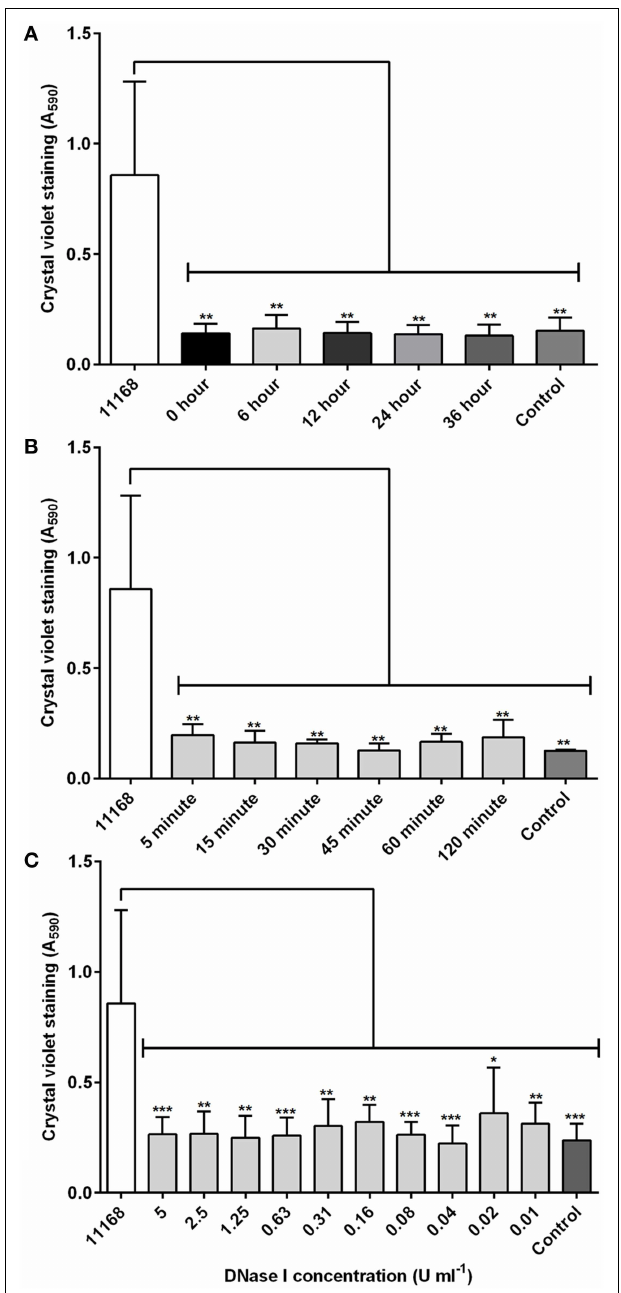
FIGURE 2 | DNase I is able to rapidly degrade C. jejuni NCTC 11168 biofilms. (A) DNase I (4units/ml) was added at defined intervals to aerobically incubated NCTC 11168 cultures over a 48h static incubation and biofilm degradation assessed by crystal violet staining. (B) Following a 48h static incubation to allow biofilm formation, DNase I was added to biofilms for between 5 and 120min before biofilm degradation was assessed. (C) The concentration of DNase I required for biofilm control was also assessed using DNase I concentrations of between 0.01 and 5U/ml. In each graph,